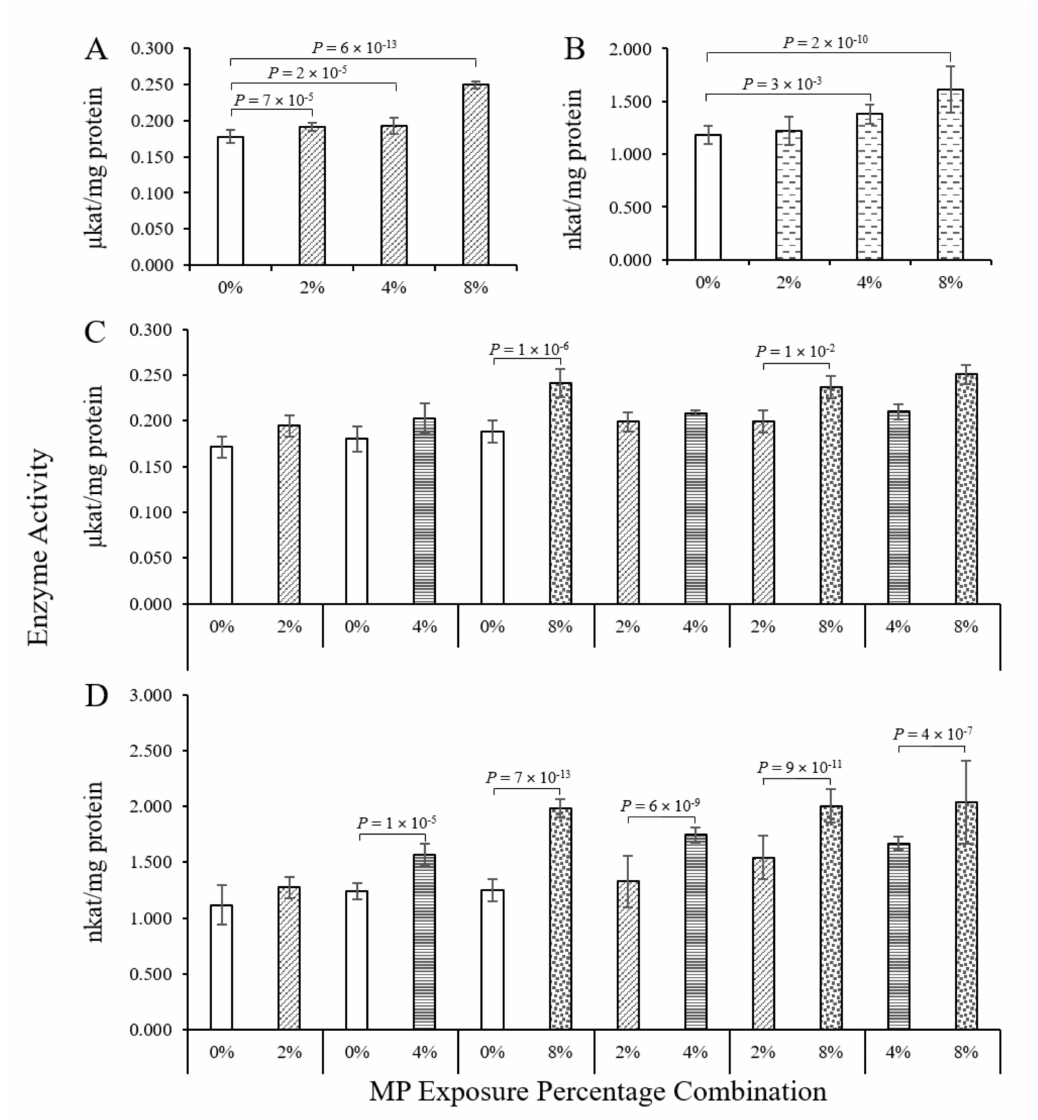
Figure 3. ( A ) Catalase activity in the 0% MP on both sides pairing, as well as in pairings with the same MP concentration on both sides. ( B ) GST activity in a 0% to 0% pairing, as well as in pairings with the same MP percentage on both sides. Data represent mean enzyme activity ± standard deviation ( n = 9, at 50 worms per independent replicate). ( C ) Catalase activity in worms from soil containing 0% to 2%; 4%, and 8% MP, as well as worms from the avoidance experiment from clean and MP-spiked sides of di ff erent MP concentrations. ( D ) Glutathione S-transferase activity in control worms from soil containing 2%, 4% and 8% MP, as well as worms from the avoidance experiment from clean and MP-spiked sides of di ff erent MP concentrations. Data represent mean enzyme activity ± standard deviation ( n = 3, at 50 worms per independent replicate). When data were not homogenously distributed, even after transformation, the non-parametric Kruskal–Wallis test with pairwise comparisons were